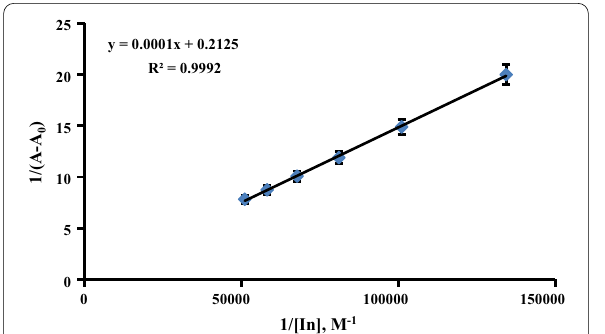
Fig. 2 B-H Plot for the interaction between In and ARS at pH 7